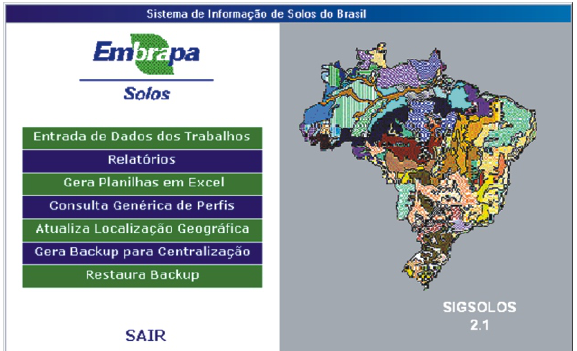
Figura 4. Tela de abertura.